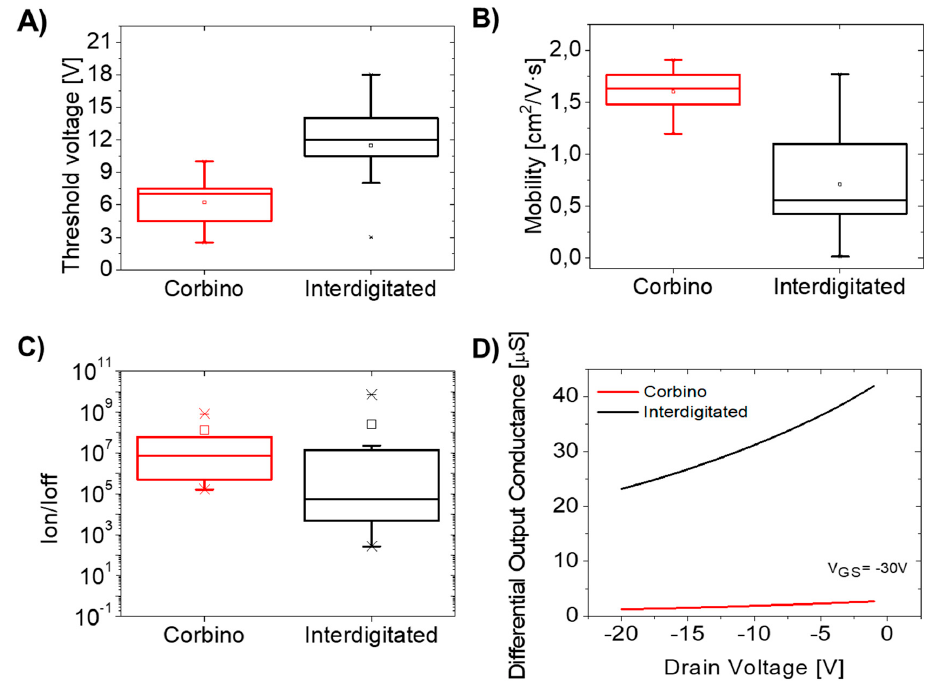
Figure 3. Electrical parameters such as ( A ) threshold voltage, ( B ) effective hole mobility and ( C ) I ON / I OFF ratio for Corbino and interdigitated geometries. The central mark represents the median, box limits indicate the 25 th and 75 th percentiles, and whiskers extend to the 5 th and 9 th percentiles. ( D ) Differential output conductance as a function of drain voltage at V GS = − 30 V.